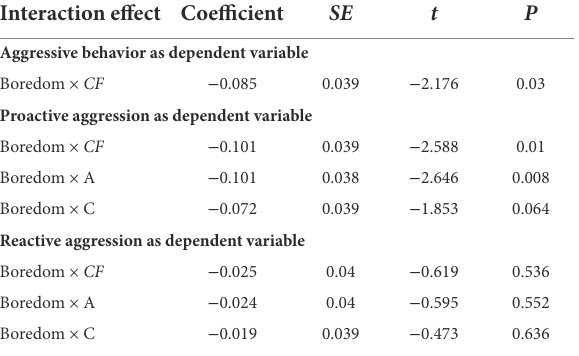
TABLE 2 Results of moderation analysis with the aggressive behavior, proactive aggression, and reactive aggression as dependent variables, boredom as the independent variable, and cognitive flexibility as the moderator.